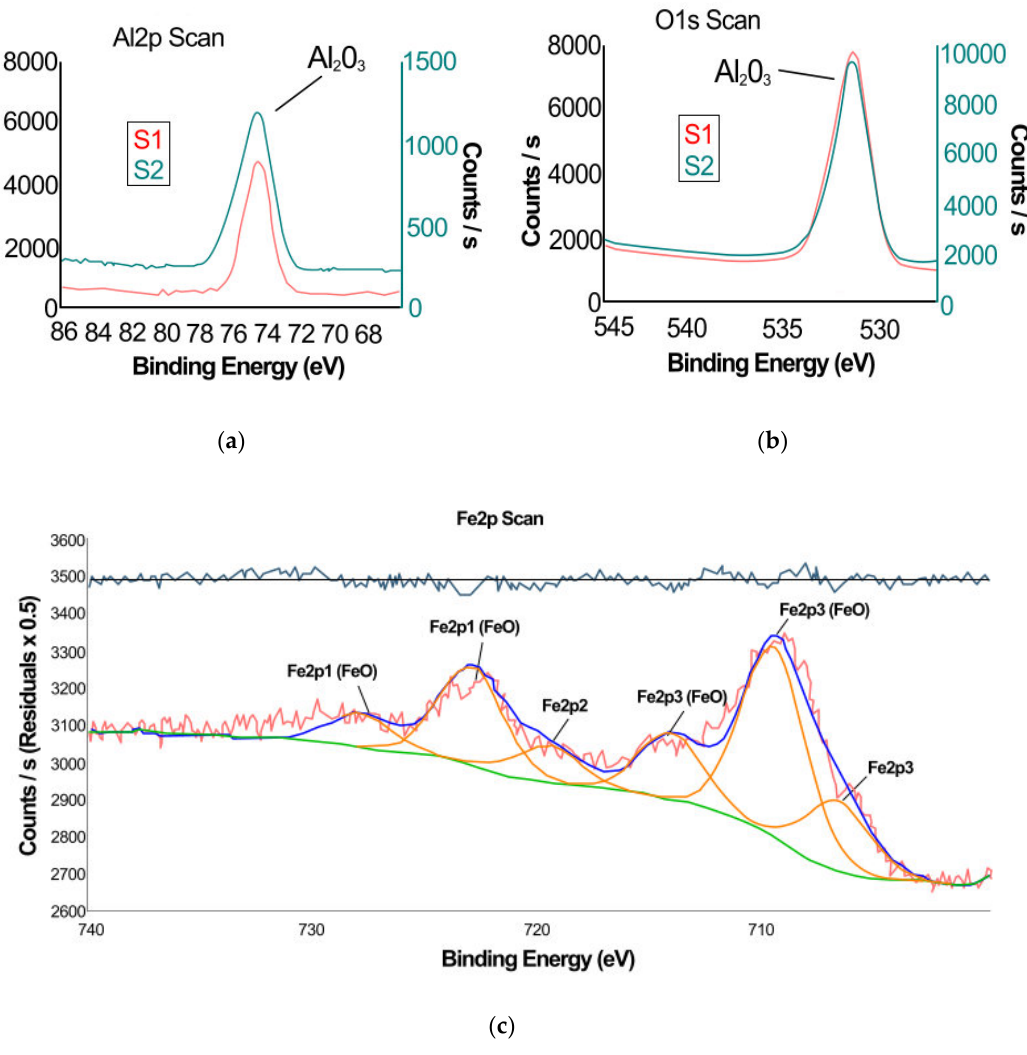
Figure 2. Overlapped XPS spectra of S1 and S2 sample: ( a ) Al2p; ( b ) O1s; ( c ) Fe2p.